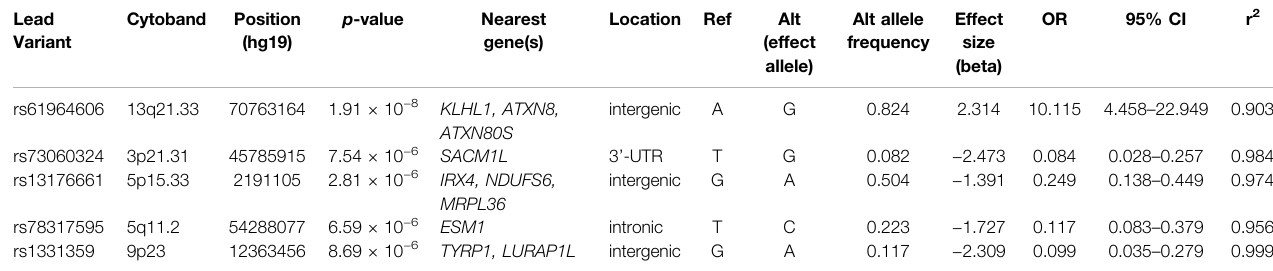
TABLE 2 | Lead variants: severe and moderate versus mild disease. Lead Variant